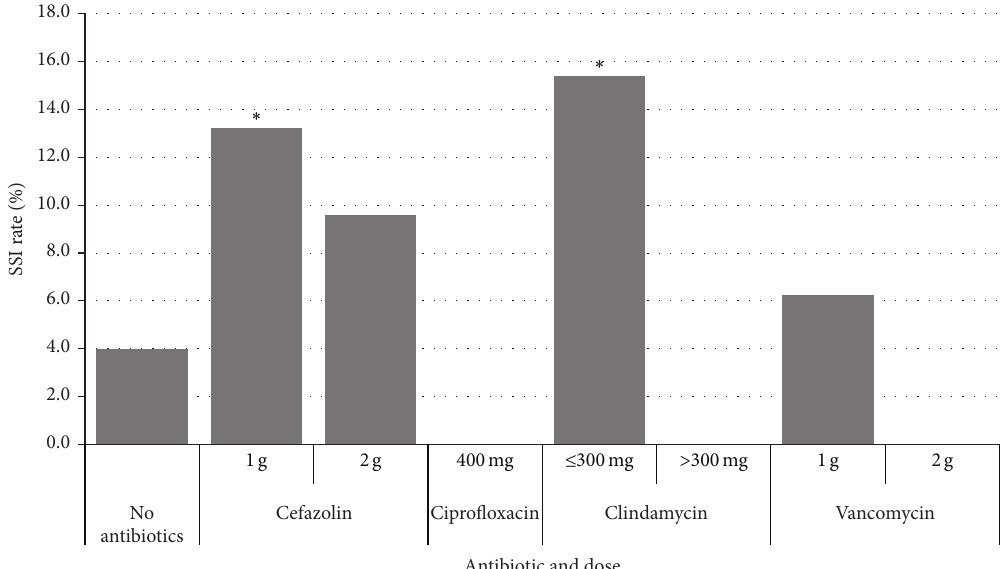
Figure 1: Surgical site infection rate by antibiotic and dose. Rates of SSI in nonreconstructive breast surgery patients were compared by antibioticanddose.Clindamycindoses ∗ of150or300mgwerecombinedas ≤ 300 mganddosesof450and600 mgwerecombinedas > 300 mg. The 1-gram cefazolin dose was associated with significantly higher rates of SSI compared to no antibiotic prophylaxis, 13.2% versus 4.0%, 𝑝 < 0.0001 . A ≤ 300 mg dose of clindamycin was also associated with significantly higher rates of SSI compared to no antibiotics, 15.4% versus 4.0%, 𝑝 = 0.027